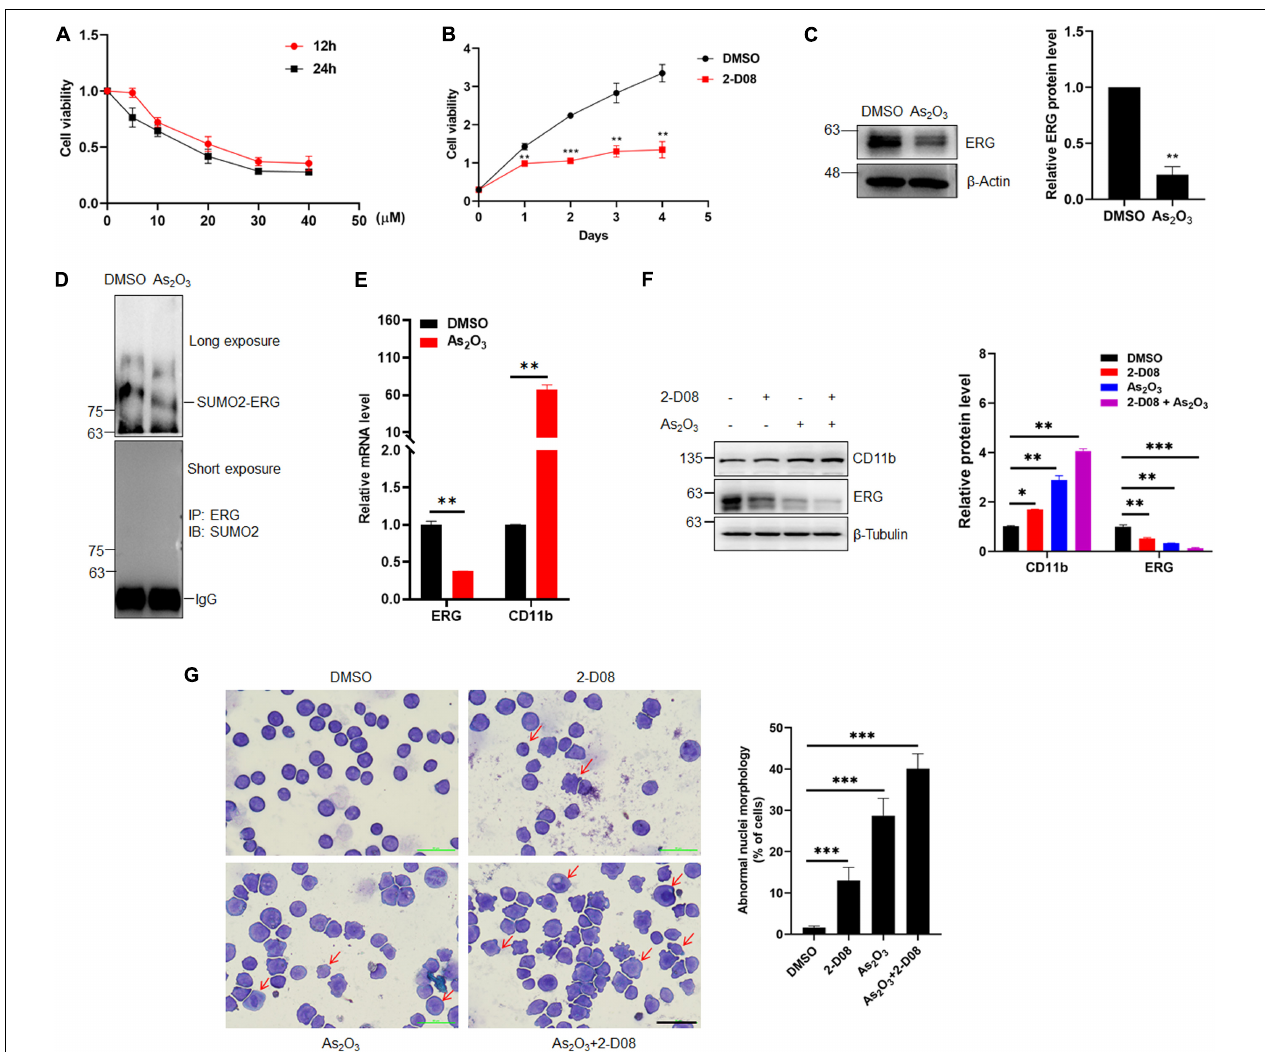
FIGURE 6 | Arsenic trioxide and SUMO inhibitor inhibited the expression of ERG and promoted cell differentiation of HL60 cells. (A) 2-D08 suppressed the viability of HL60 cells in a concentration-dependent manner. HL60 cells were incubated with the indicated concentrations of 2-D08 or DMSO for 12 or 24 h and cell viability was measured using MTT assay ( n = 3 repeats/group, one-way ANOVA). (B) 2-D08 suppressed the viability of HL60 cells in a time-dependent manner. HL60 cells were incubated with 20 µ M 2-D08 or DMSO for different periods of time and cell viability was measured using MTT assay ( n = 3 repeats/group, one-way ANOVA, ** p < 0.01, *** p < 0.001). (C) Arsenic trioxide decreased the expression level of ERG in HL60 cells. HL60 cells were treated with As 2 O 3 for 24 h, and the cell lysates were detected by IB with anti-ERG or anti- β -actin antibodies (left). The results of quantitative analysis of Western blot are shown in the right panel ( n = 3 repeats/group, Student’s t -test, ** p < 0.01). (D) Arsenic trioxide decreased the SUMOylation level of ERG in HL60 cells. HL60 cells were treated with As 2 O 3 for 24 h, and the IP with ERG from cell lysates were detected by IB with anti-SUMO2 antibody. (E) The mRNA level of CD11b was decreased after As 2 O 3 treatment in HL60 cells. The expression levels of ERG and CD11b transcripts after As 2 O 3 treatment in HL60 cells were measured by real-time PCR and normalized to DMSO control cells ( n = 3 repeats/group, one-way ANOVA, ** p < 0.01). (F) Arsenic trioxide and 2-D08 enhanced CD11b expression and inhibited ERG expression in HL60 cells. HL60 cells were treated with As 2 O 3 and 2-D08 for 24 h, and the cell lysates were detected by IB with CD11b, anti-ERG, or anti- β -actin antibodies (left). The results of quantitative analysis of Western blot are shown in the right panel ( n = 3 repeats/group, two-way ANOVA, * p < 0.05, ** p < 0.01, *** p < 0.001). (G) Arsenic trioxide and 2-D08 promoted cell differentiation of HL60 cells. HL60 cells were treated with As 2 O 3 and 2-D08 for 24 h, and the cell morphology was indicated by Giemsa staining (left). The results of quantitative analysis of differentiated cells are shown in the right panel ( n = 3 repeats/group, one-way ANOVA, ∗∗∗ p < 0.001). The scale bar is 100 µ